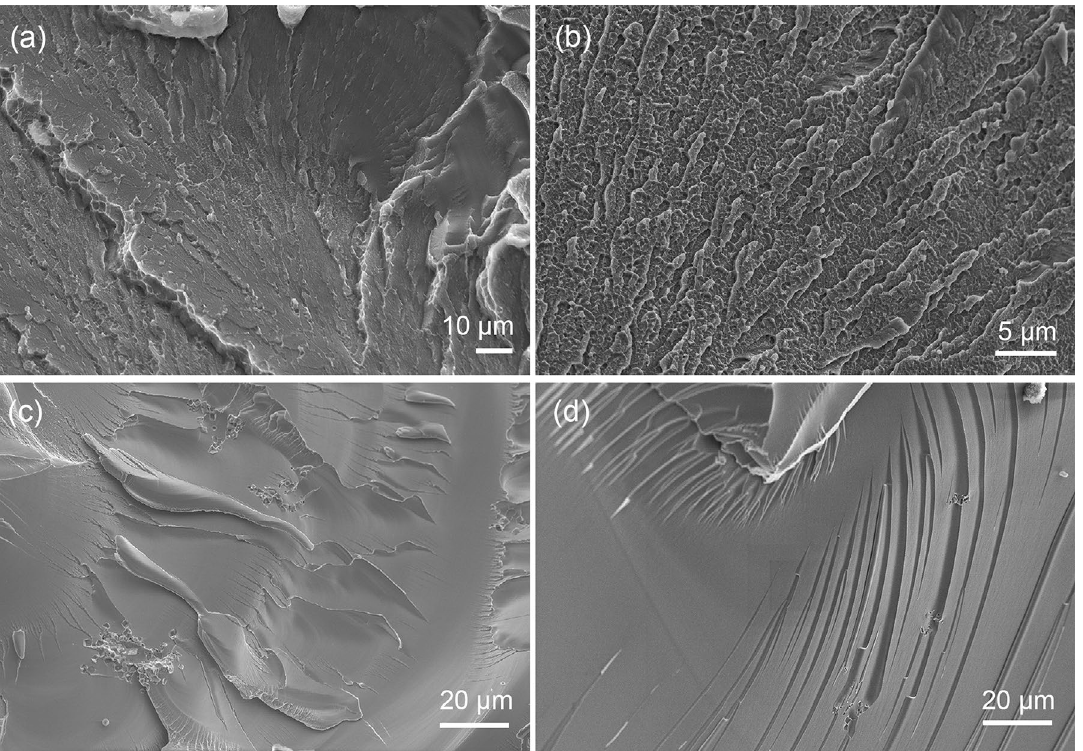
Figure 9. The fracture surface SEM images of the samples annealed at higher temperatures: (a), (b) 740 K; (c), (d) 760 K.